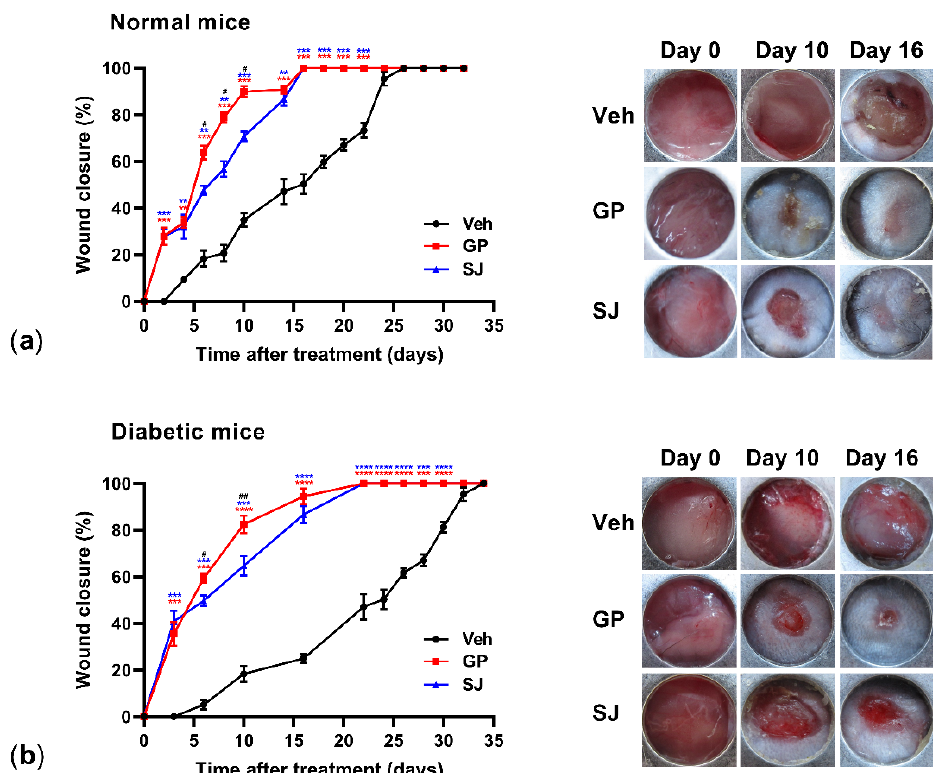
Figure 2. G. procumbens accelerates wound healing in the normal and diabetic mice: Dorsal full- thickness dermal wounds were created on ( a ) normal mice and ( b ) streptozotocin-induced diabetic mice and treated with Vaseline (Veh), 0.5% G. procumbens (GP) or 10% solcoseryl jelly (SJ) for up to 35 days. The left panels show the percentage of wound closure (n = 5 mice/group). Values represent the means ± SD, n = 5 mice/group. ** p < 0.01, *** p < 0.001 and **** p < 0.0001 for the comparisons between Vaseline (Veh: vehicle) and G. procumbens (GP, red) or solcoseryl jelly (SJ, blue). # p < 0.05 and ## p < 0.01 for the comparisons between G. procumbens (GP) and solcoseryl jelly (SJ). Right panels: representative photographs of wounds treated with Vaseline (Veh: vehicle), G. procumbens (GP) or solcoseryl jelly (SJ) on days 0, 10 and 16.